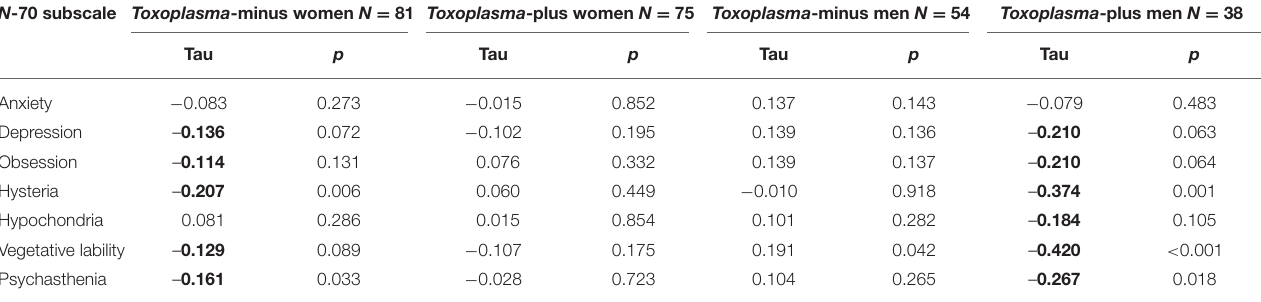
TABLE 2 | Correlation between Bartonella seropositivity and seven subscales of neuroticism in Toxoplasma -seronegative and Toxoplasma -seropositive subjects. N -70 subscale Toxoplasma -minus women N = 81 Toxoplasma -plus women N = 75 Toxoplasma -minus men N = 54